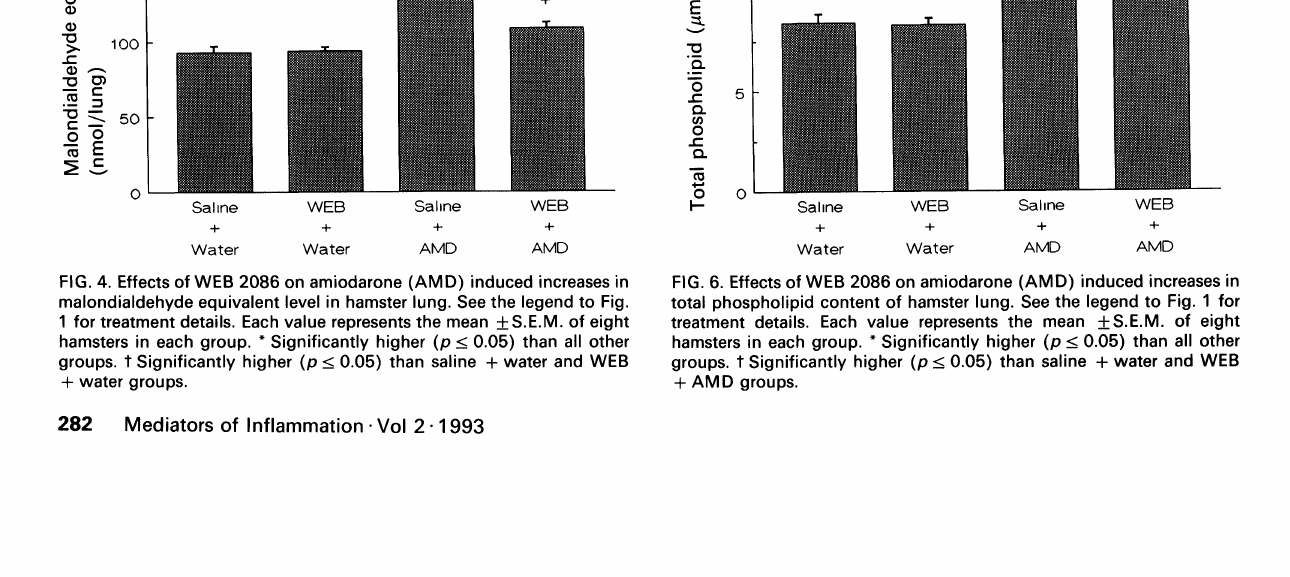
___ FIG. 6. Effects of WEB 2086 on amiodarone (AMD) induced increases in total phospholipid content of hamster lung. See the legend to Fig. for S.E.M. of eight treatment details. Each value represents the mean -I-S.E.M. of eight hamsters in each group. Significantly higher (p < 0.05) than all other groups, Significantly higher (p < 0.05) than saline + water and WEB + AMD